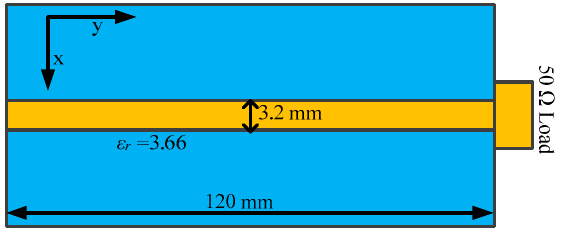
Figure 8. Top view of the characterizing microstrip line.